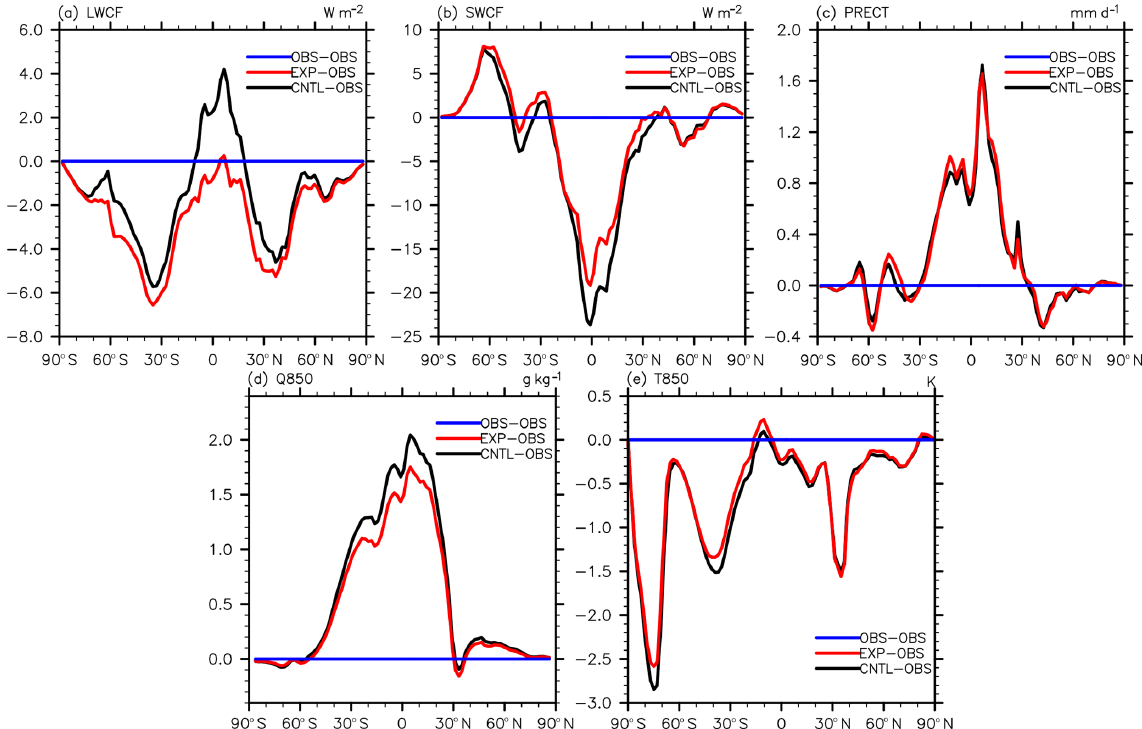
Figure 4. Meridional distribution of the difference between EXP/CNTL and observed data of (a) LWCF, (b) SWCF, (c) PRECT, (d) Q850, and (e) T850. The position of the dark blue line is 0; the red and black solid lines represent the difference between EXP / CNTL and the observations.